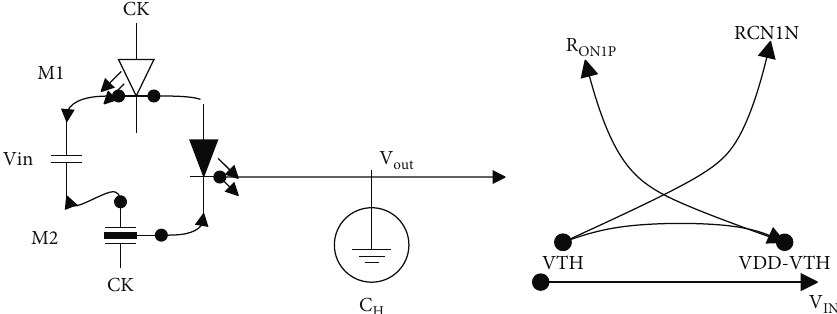
Figure 5: CMOS switch and its